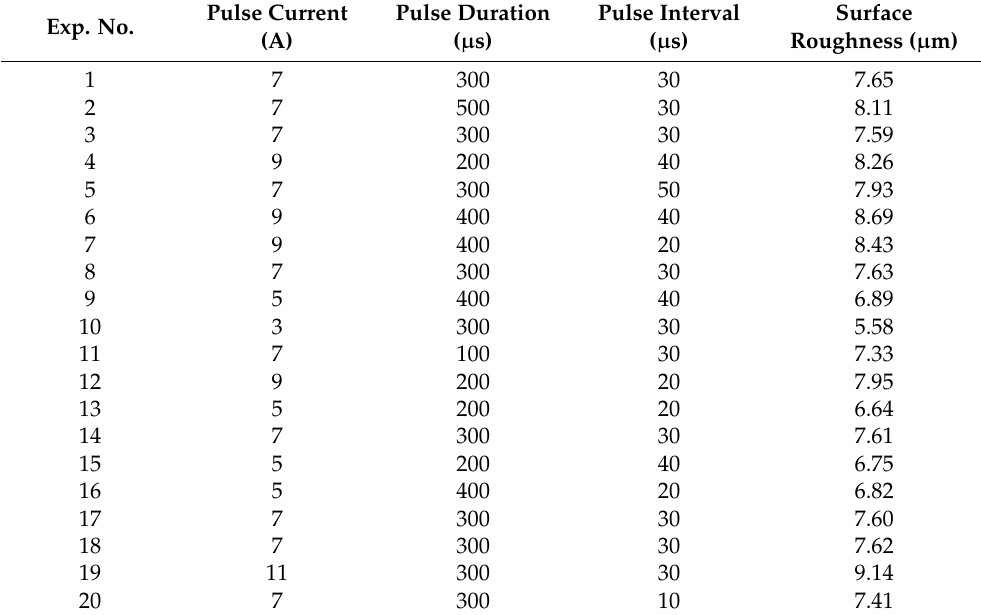
Table 4. Experimental response of surface